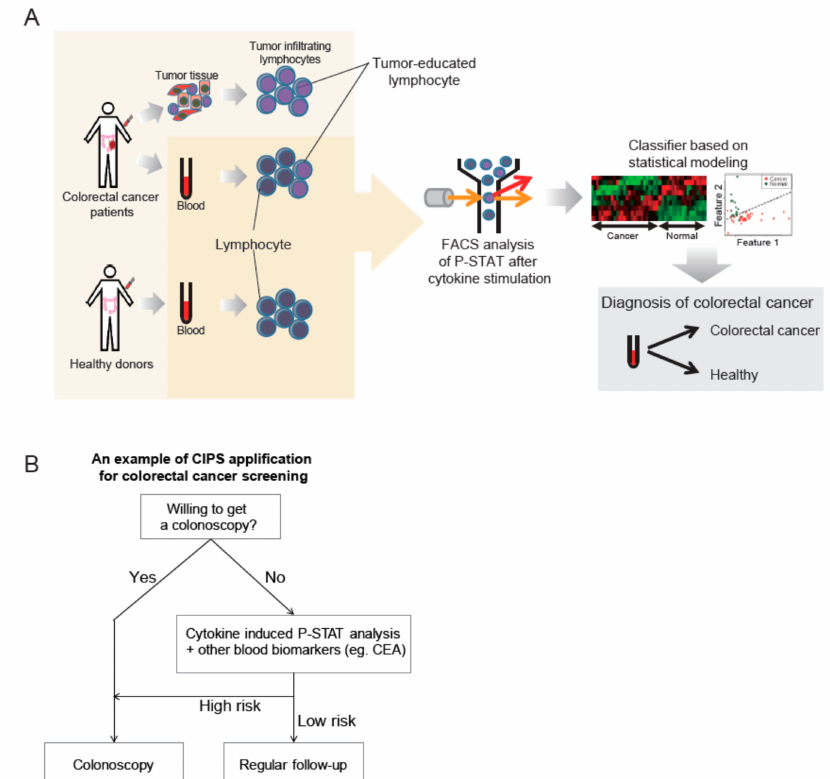
Figure 5. ( A ) Graphical overview of a novel type of biomarker, the cytokine induced p-STAT